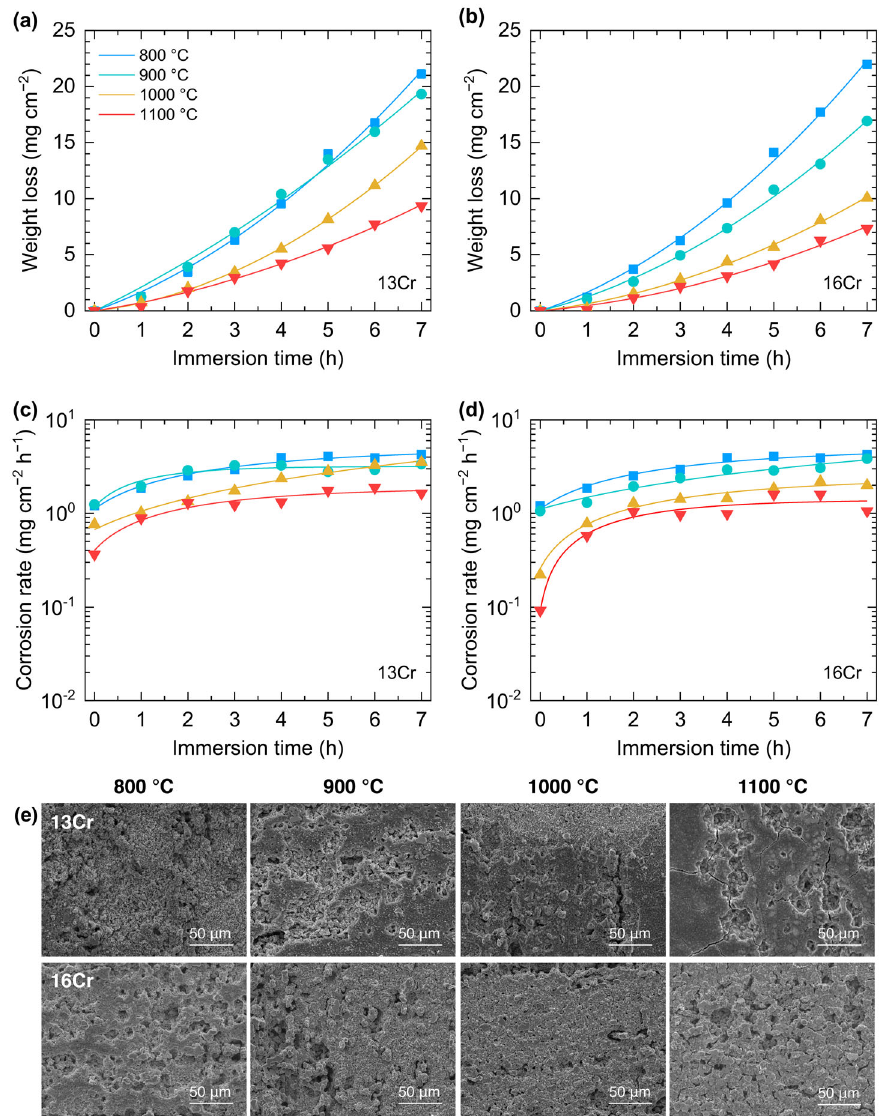
Fig. 4 Corrosion performance of the of the developed steels measured by immersion tests. a , b Weight loss and c , d corrosion rate plotted as functions of the immersion time for the a , c 13Cr and b , d 16Cr steels in the 0.5 M H 2 SO 4 solution. e SEM images of the 13Cr and 16Cr steels heat treated at different temperatures after the 7-h